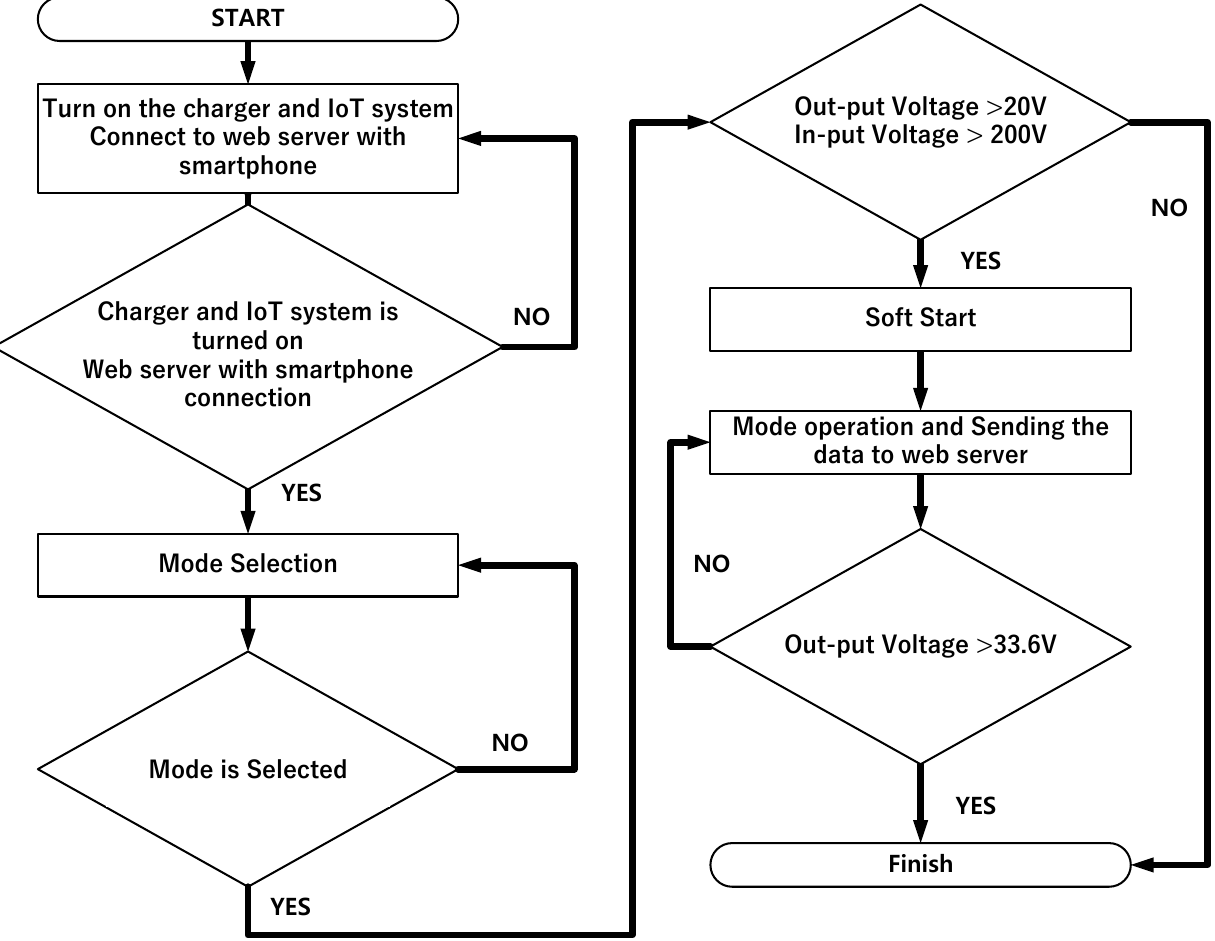
Figure 6. Flow chart of the IoT controller.